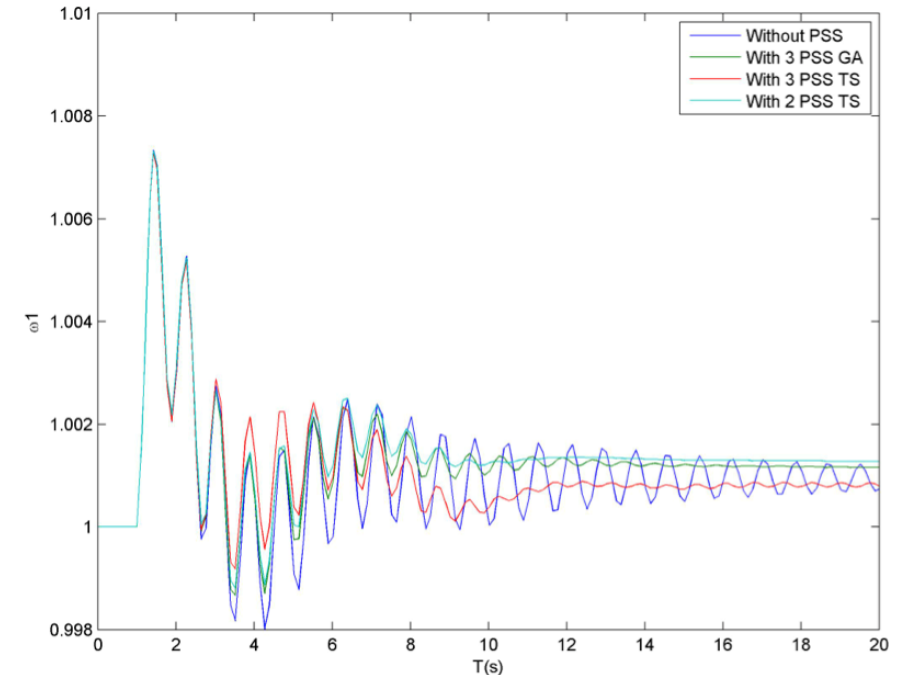
Figure 6. Velocity response of the three-machine—nine-busbar IEEE system when a fault occurs at busbar 4, considering the different scenarios of the controllers’ parameters. Angular velocity ω 1 is shown in dependence of time T in seconds.